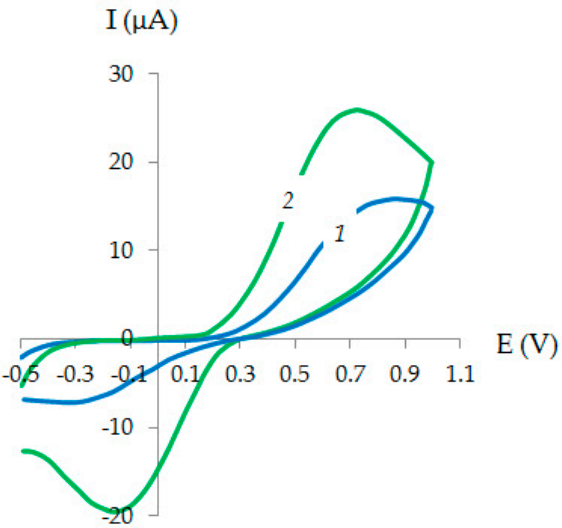
Figure 4. Cyclic voltammograms of 1 mM [Fe(CN) 6 ] 4 − on CVE ( 1 ) and Au-gr/CVE ( 2 ) in 0.1 M KCl. ν = 0.05 Vs − 1 .